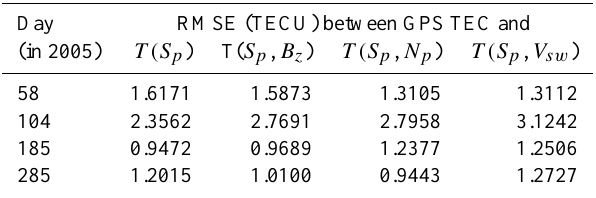
Table 2. RMSE between GPS TEC and predicted TEC values for days 58, 104, 185 and 285 in